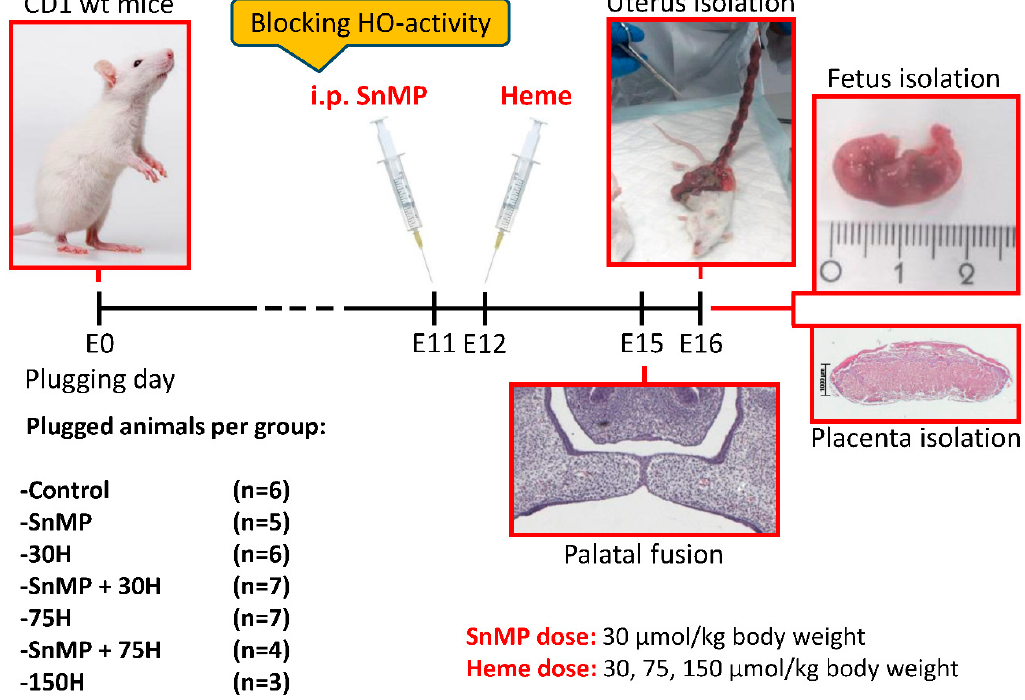
Figure 6. Administration of heme and / or SnMP in plugged mice via intraperitoneal injection. Plugged mice received SnMP (30 µ mol / kg body weight) at Day E11 and / or heme in different dose (30, 75 and 150 µ mol / kg body weight) at Day E12 by i.p. injection. All plugged mice were killed by CO 2 / O 2 inhalation for 10 min at Day E16; the uteri were removed; and the fetuses and placentas were isolated. The first animals that